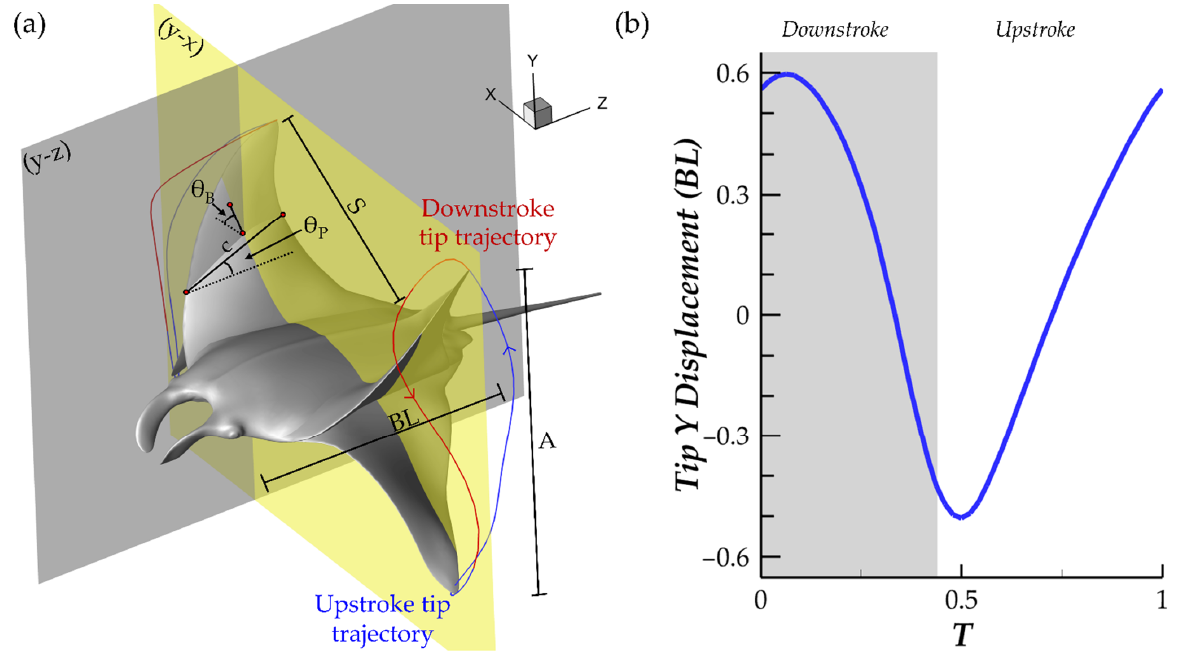
Figure 2. ( a ) Geometric variables for the manta ray model along with fin tip trajectories illustrating manta-like flapping motion during the downstroke (red trajectory) and upstroke (blue trajectory); ( b ) fin tip y-displacement .